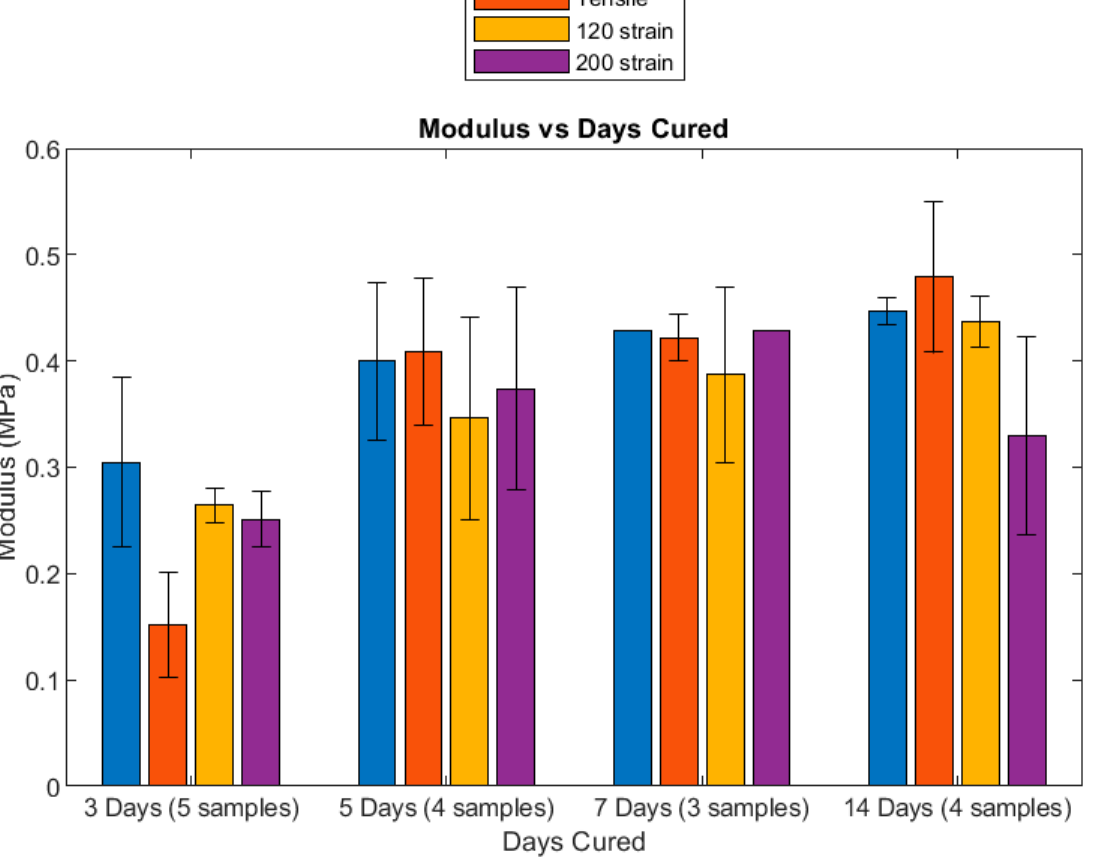
Figure 2. Bar graph of modulus versus cure time at various percent strains calculated using the resonant frequency peak in Figure 1 and Equation (1). Note the bars labeled 0%, 120%, and 200% denote the moduli calculated using VOCT at that those strains, while the tensile bar denotes the modulus calculated by the stress–strain curve of the tensile test. The standard deviation for each specimen condition is indicated except for the specimens cured for 7 days at 0% and 200% strain because their standard deviations were zero. Note the modulus obtained by traditional destructive uniaxial tensile testing (tensile) is similar to the modulus obtained by VOCT, especially for the specimens cured for 5 and 7 days (see Figures 2 and 3). VOCT-calculated modulus for specimens cured for 7 days is the closest to the tensile testing at 0%, 120%, and 200% strain.